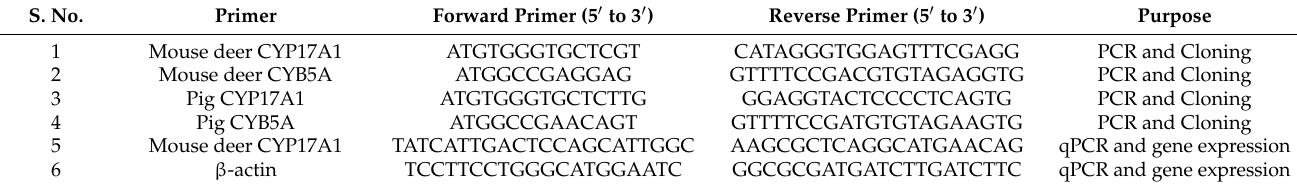
Table 2. Primers used for the amplification of sequences of CYP17A1 and CYB5A for PCR, cloning, and quantitative PCR for relative quantification of CYP17A1 and β -actin in mouse